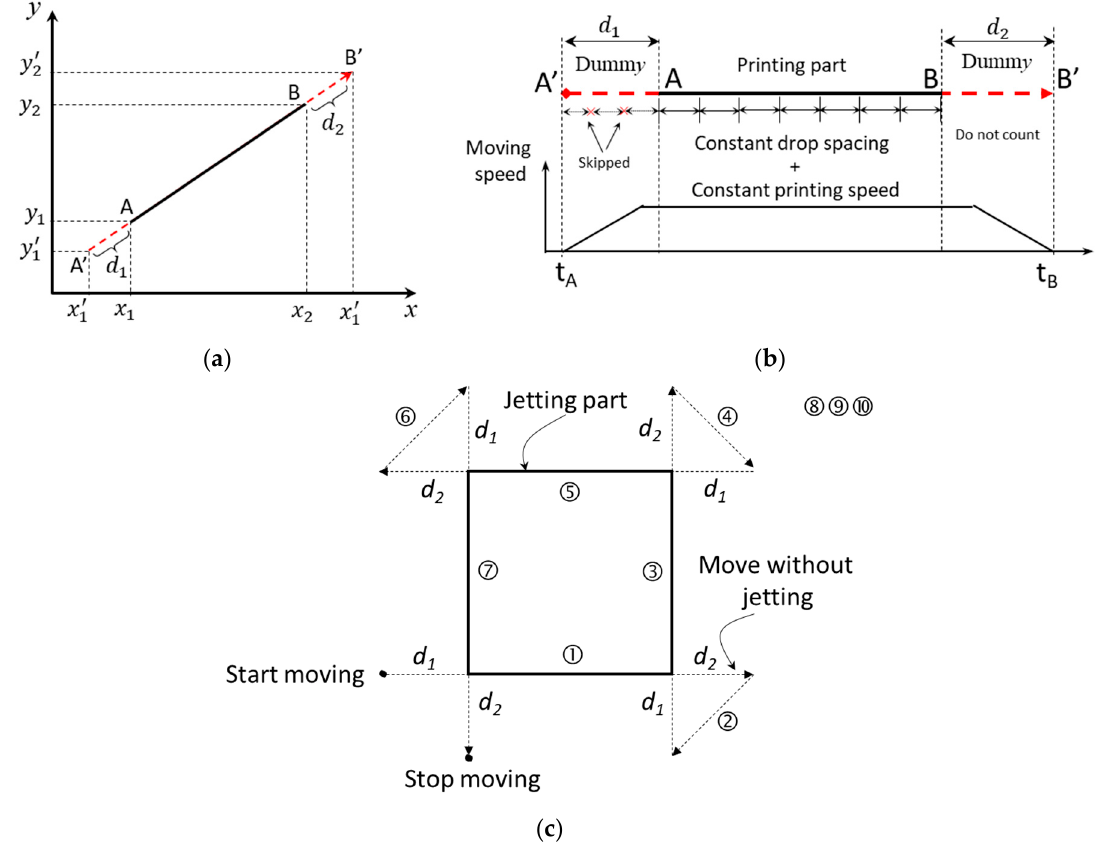
Figure 8. Vector printing using pre-set dummy distance. ( a ) Vector movement considering dummy distance; ( b ) jetting region according to pre-set dummy distance method; and ( c ) printing sequence using dummy length, an example of printing a square.